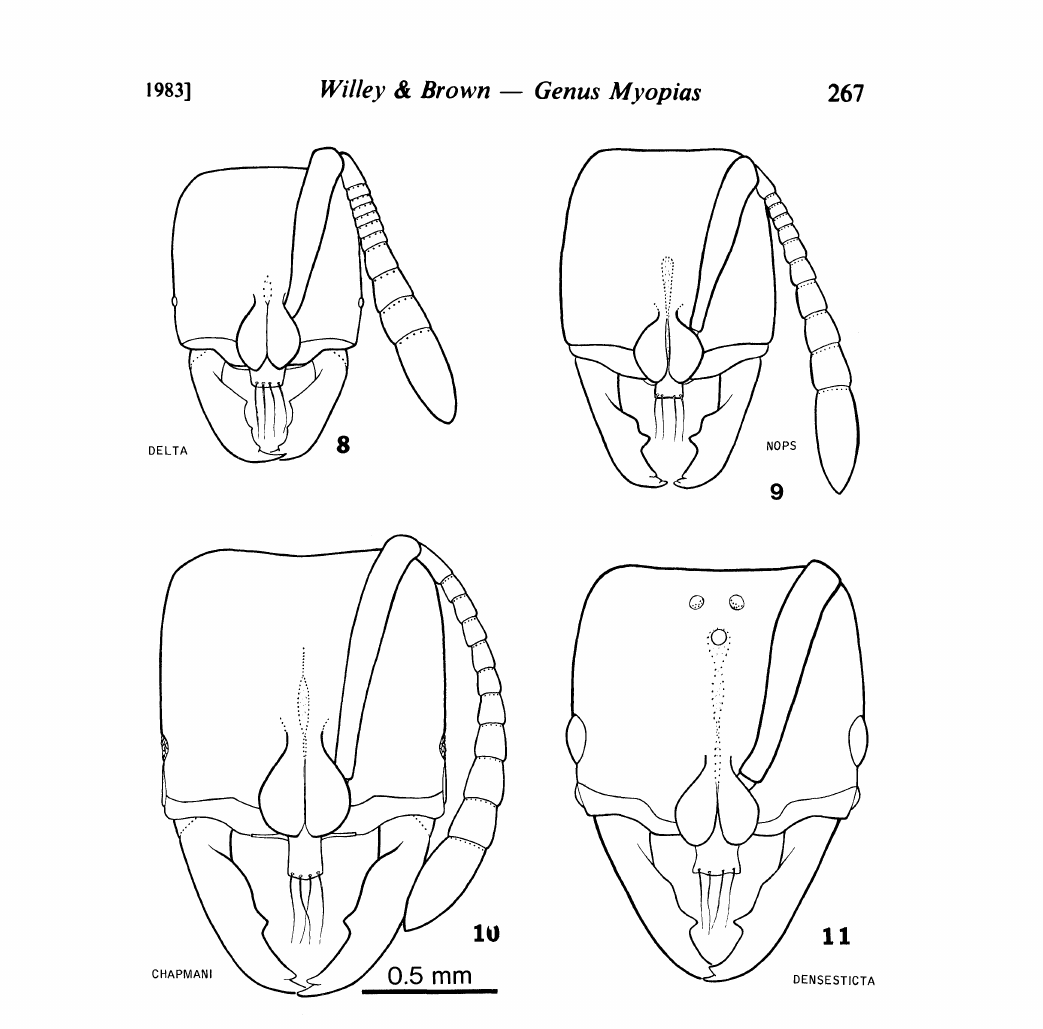
Figs. 8-11, Myopias spp., heads in full-face view, sculpture and pilosity omitted. Fig. 8, M. delta, paratype worker. Fig. 9, M. hops, holotype worker. Fig. 10, M. chapmanL paratype worker. Fig. 11, M. densesticta, paratype queen from Kuranda, Queensland. All to same